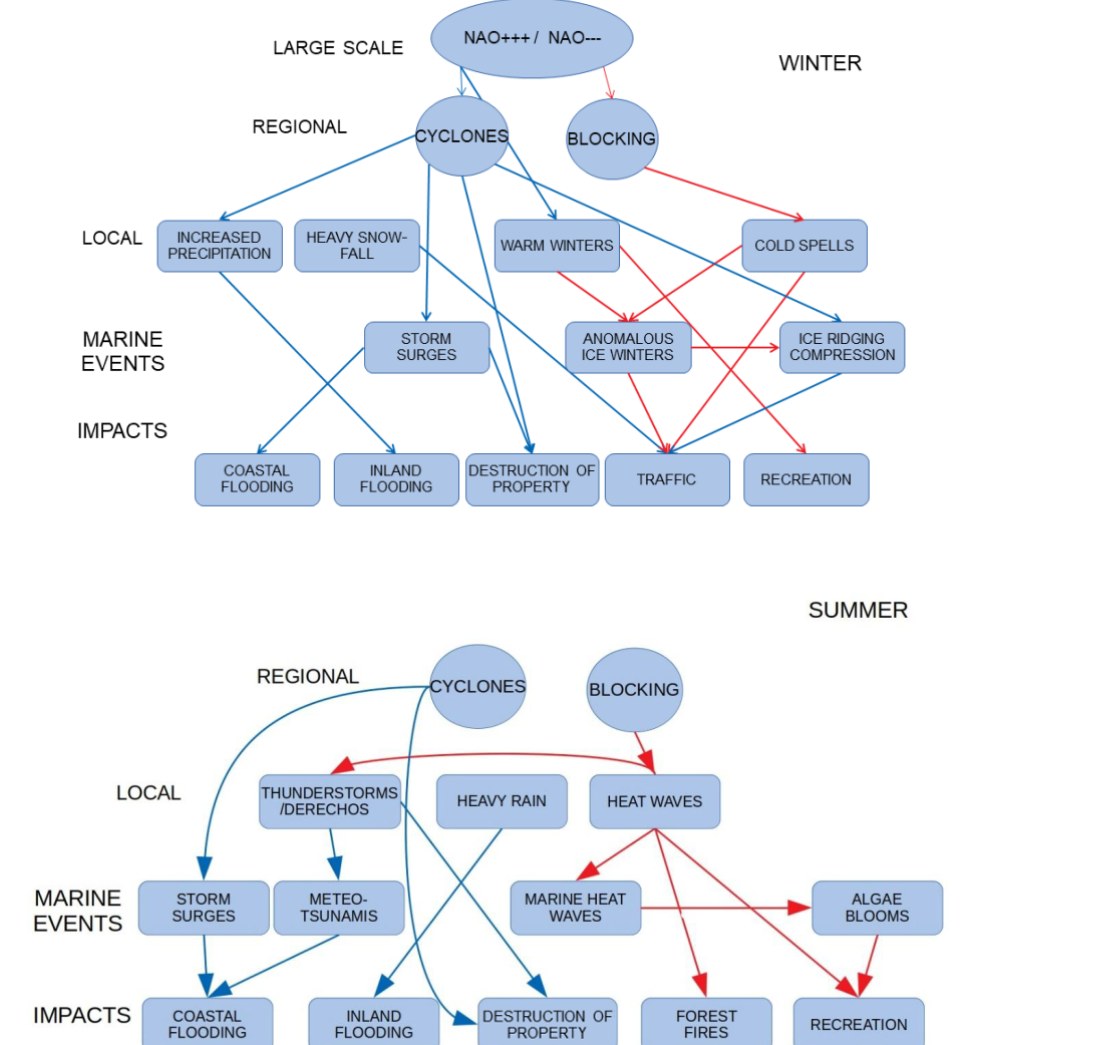
Figure 14. Simplified diagram to illustrate the relationship between atmospheric, hydrological, and marine processes as well as their impact on society in winter and